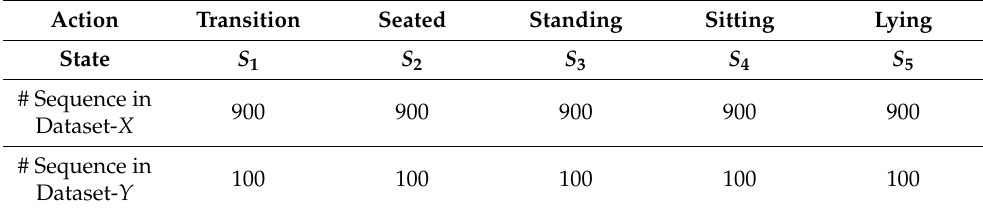
Table 2. Training datasets used for calculating HMM emission probability distribution B .